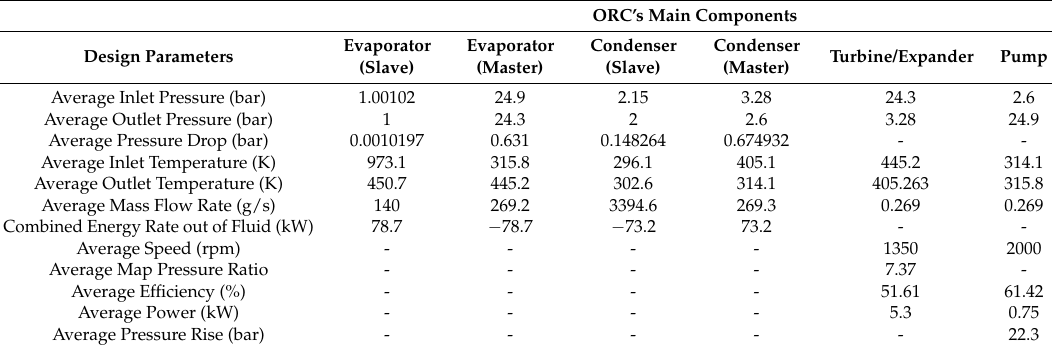
Table 2. Component design parameters of ORC using R245fa